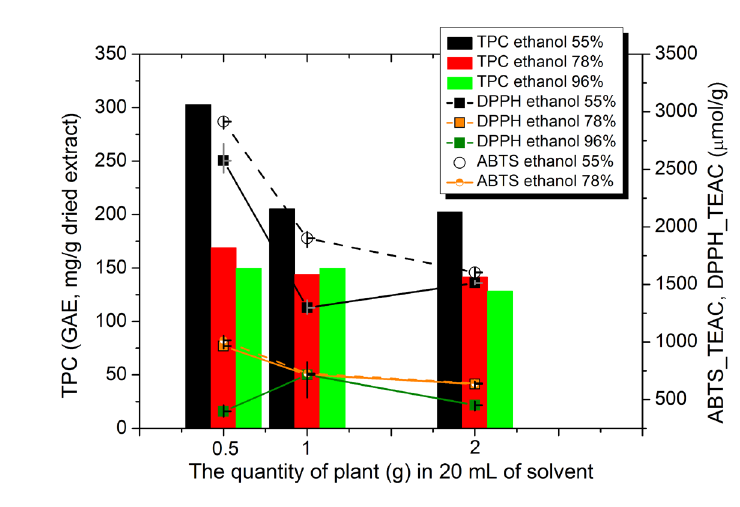
Figure 8. The influence of the quantity of plant (g) in 20 mL of solvent on: a) the total polyphenolic content expressed as gallic acid equivalents (GAE, mg g -1 dried extract) vs. ethanol 55%, 78% and 96%; b) antioxidant capacity of the 55% and 78% ethanol extracts expressed as Trolox equivalents (TEAC, µ mol g -1 ) vs. ABTS and DPPH assays; Time: 60 min, Temperature: 323.15 K. Table 2. The results of correlation between TPC vs . DPPH, TPC vs . ABTS and ABTS vs.